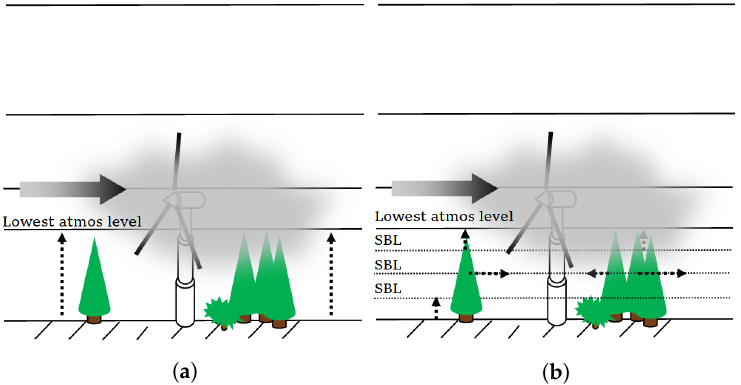
Figure 1. Examples of different surface boundary layer (SBL) schemes: ( a ) single layer SBL and ( b ) multilayer canopy scheme described in Masson and Seity